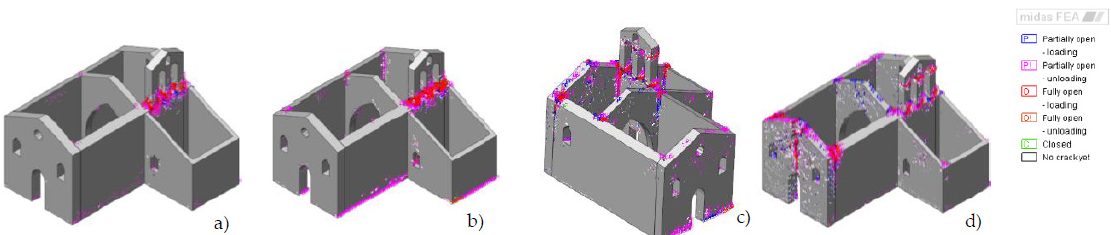
Figure 14. Numerical damage for Sant’Antonio Church in Ussita (Macerata, Central Italy) for PushMass + x ( a ), PushMass − x ( b ), PushMass + y ( c ), PushMass − y ( d ).